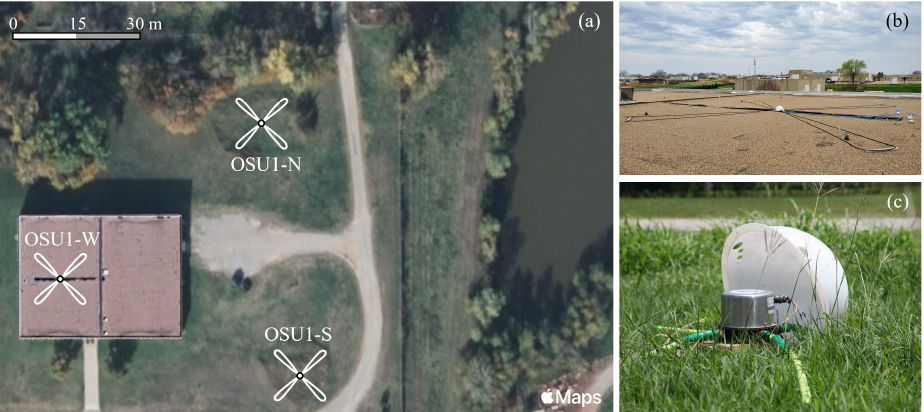
Table 1. Summary of microphone locations (including elevation, z ), mounting location (roof or ground), and the separation distance between the microphones.